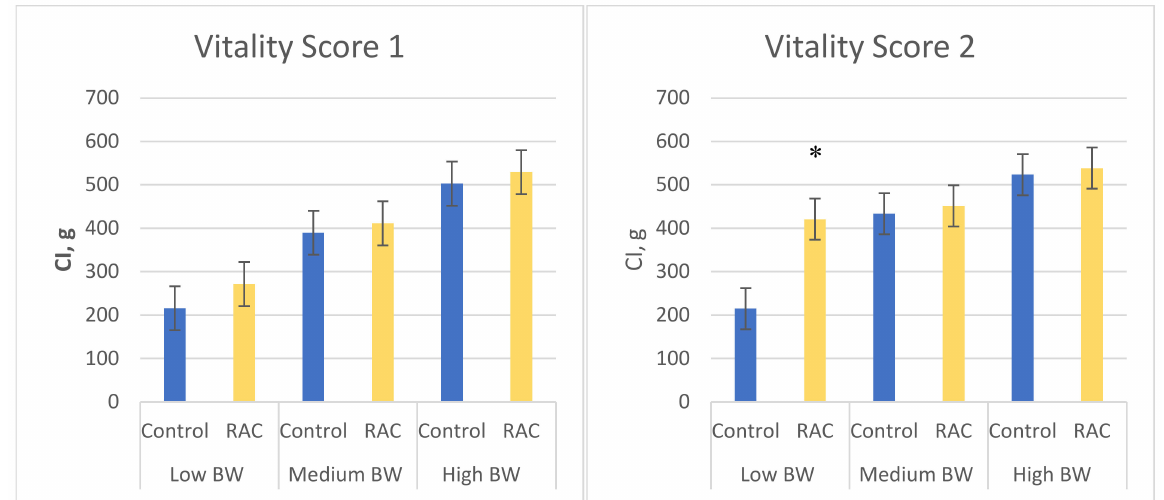
Figure 2. Piglet colostrum intake by vitality score, and sow treatments. Values are means ± SEMs, n = 236, vitality 1 piglets—no or weak movements, n = 210, vitality 2 piglets—body or limb movement obvious/rigorous. CI, g = colostrum intake in grams; BWB = body weights at birth; RAC = resin acid-enriched composition. * p <